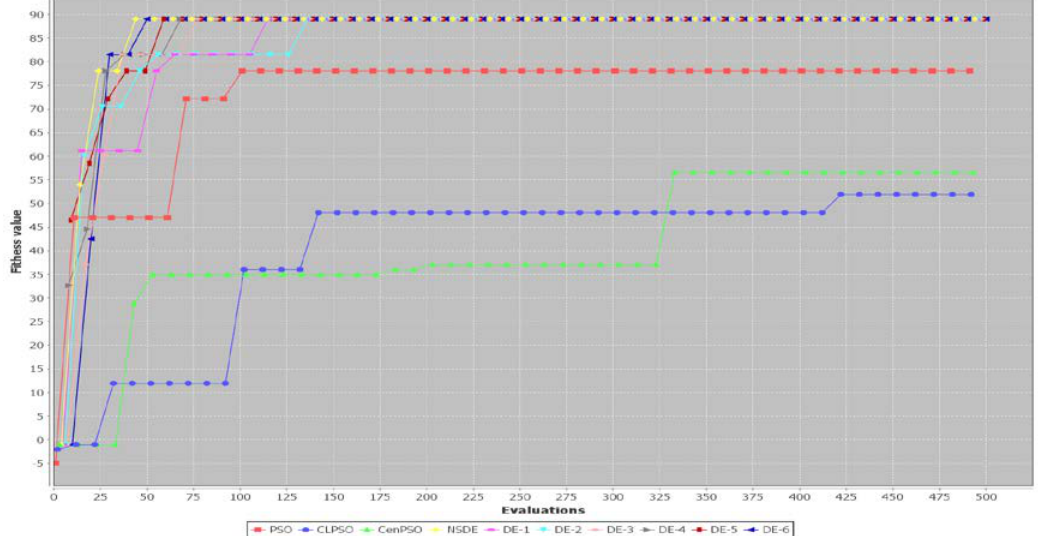
Figure A7. Convergence speed of a run of each algorithm for Case 7 with POP = 30.